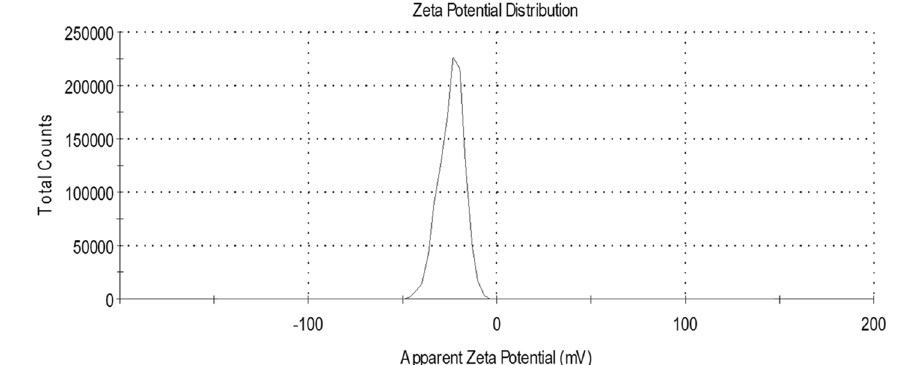
Figure 6. Zeta potential of the green synthesized